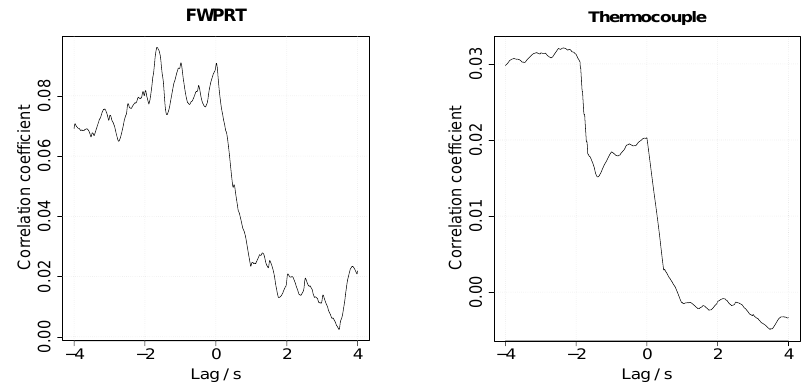
Fig. 14. Correlation function between measurements of two temperature sensors and true airspeed.